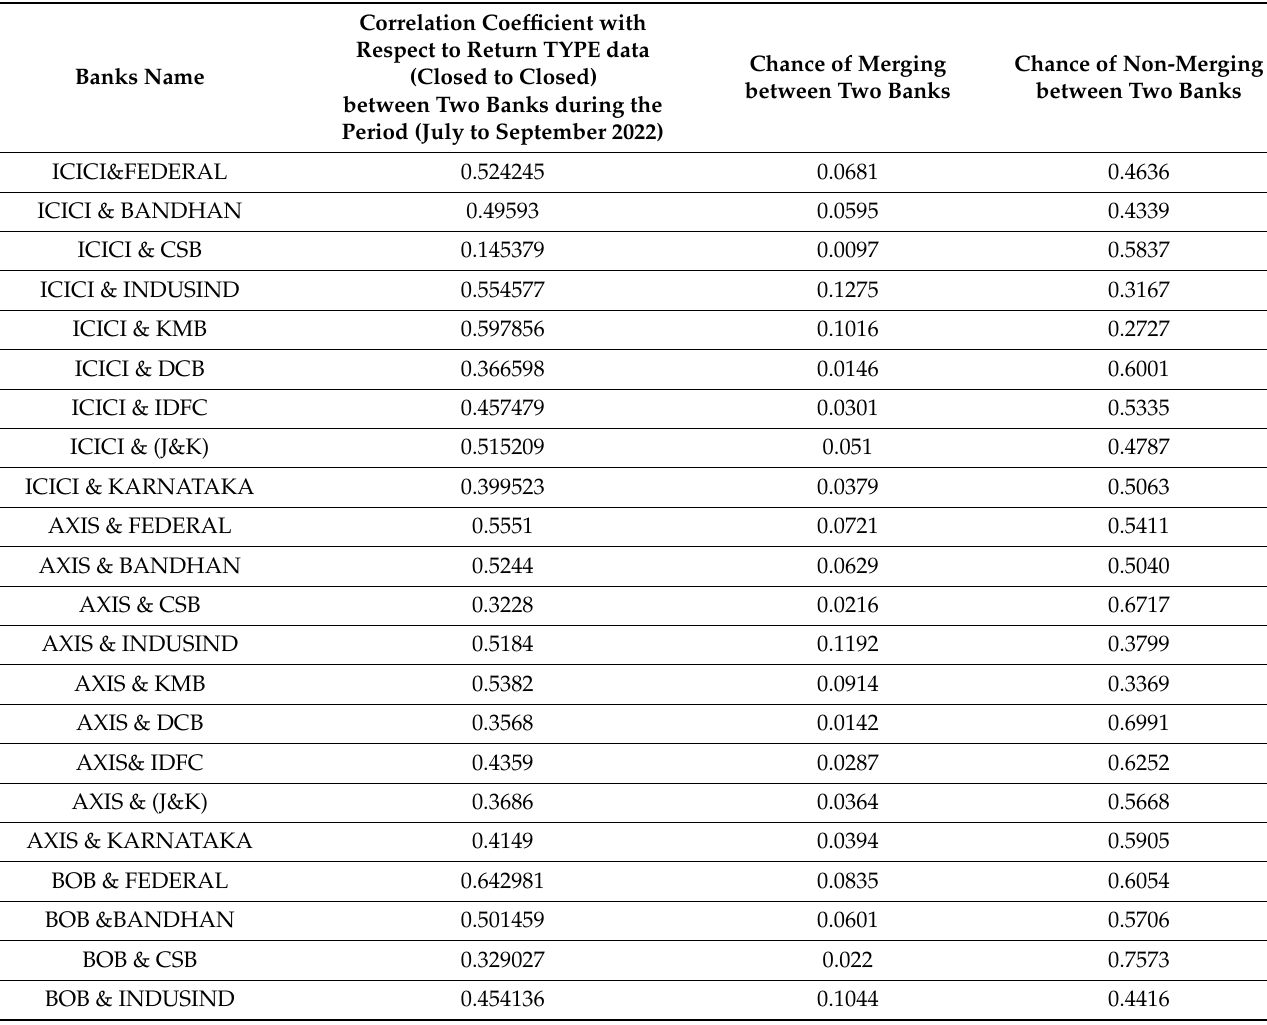
Table 5. List of banks with correlation